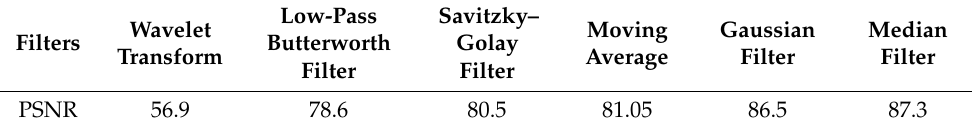
Table 2. Comparison of the filters.